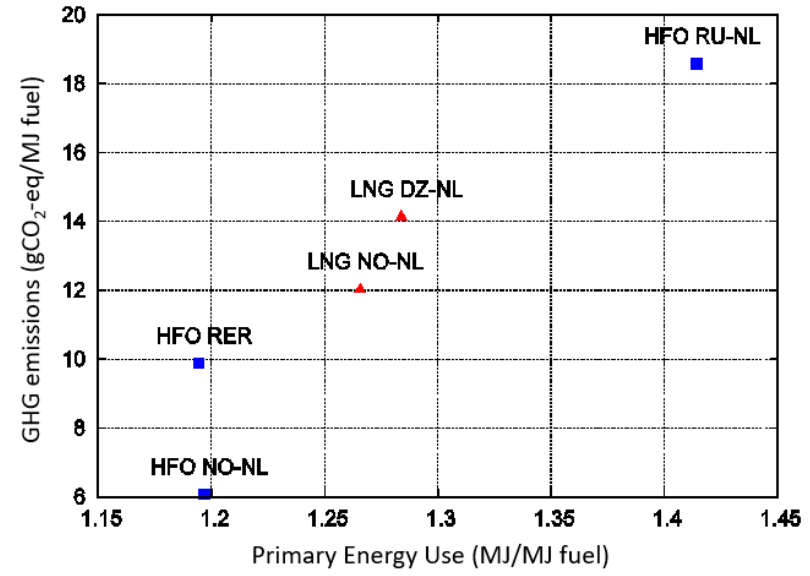
Figure 3. Cradle-to-tank GHG emissions and PEU per MJ fuel at the bunker station.